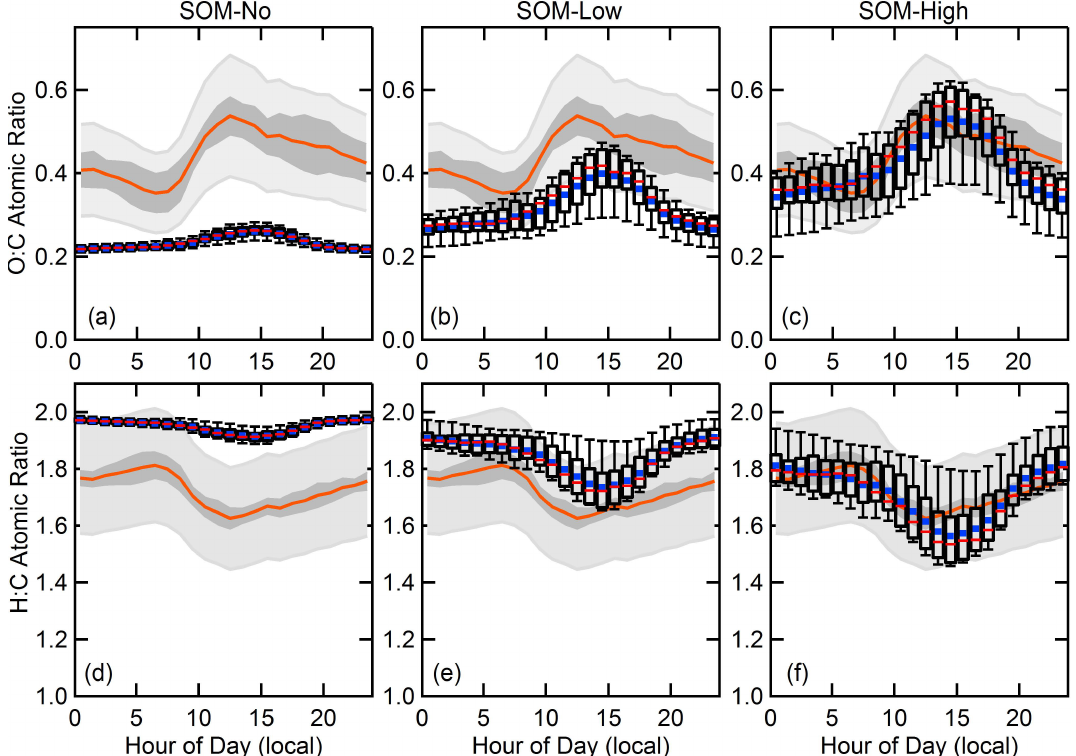
Figure 8. Simulated and observed diurnal profiles for the total OA O:C (a, b, c) and H:C (d, e, f) atomic ratios at Riverside, CA, during the SOAR-2005 campaign for (a, d) SOM-no, (b, e) SOM-low and (c, f) SOM-high simulations. For the observations, the mean (orange line) and the 1 σ variability range (dark grey band) are shown along with bands indicating the measurement uncertainty (light grey band), taken as ± 28% for O:C and 13% for H:C (Canagaratna et al., 2015). Observed values have been corrected according to Canagaratna et al. (2015). For the simulations, box and whisker plots are shown with the median (red –), lower and upper quartile (boxes), and 9th and 91st percentile (whiskers). For reference, the assumed O:C for POA was 0.2 and for H:C was